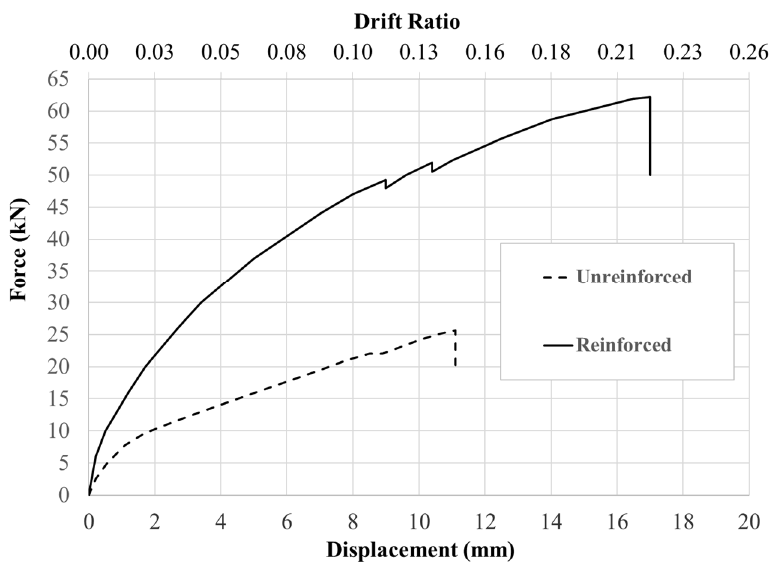
Figure 18. Force–displacement curves for the two walls under the applied lateral load. (Note: displacement is measured at the top beam above the walls.)